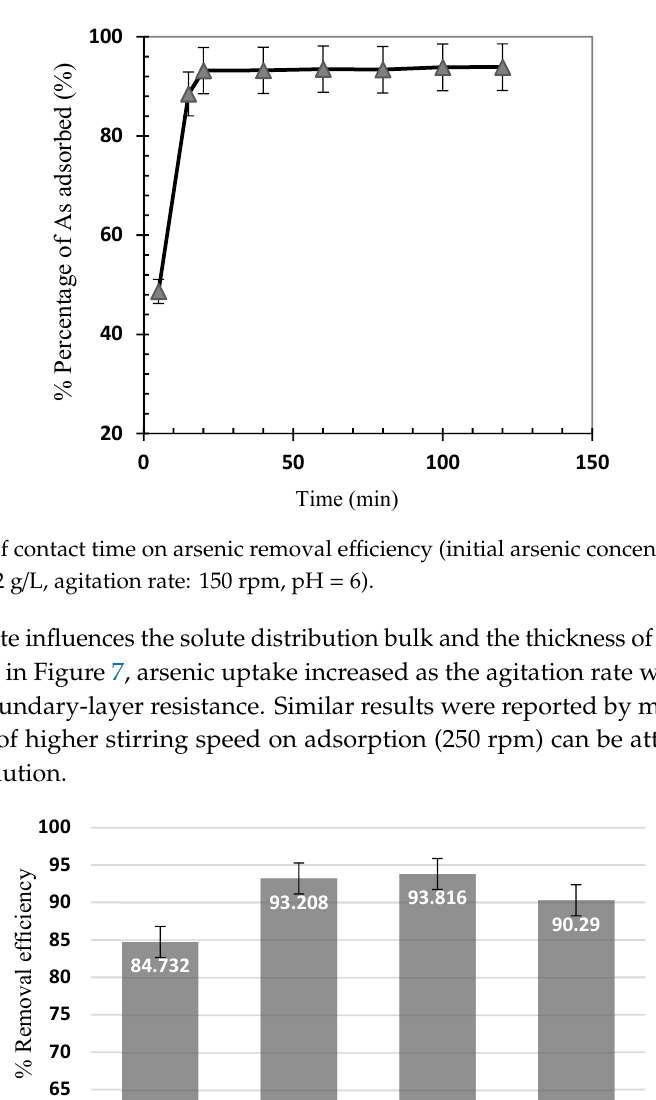
Figure 7. Effect of agitation rate variation on arsenic removal efficiency (initial arsenic concentration: 0.075 g/L, sorbent dosage: 2 g/L, contact time: 20 min, pH = 6).